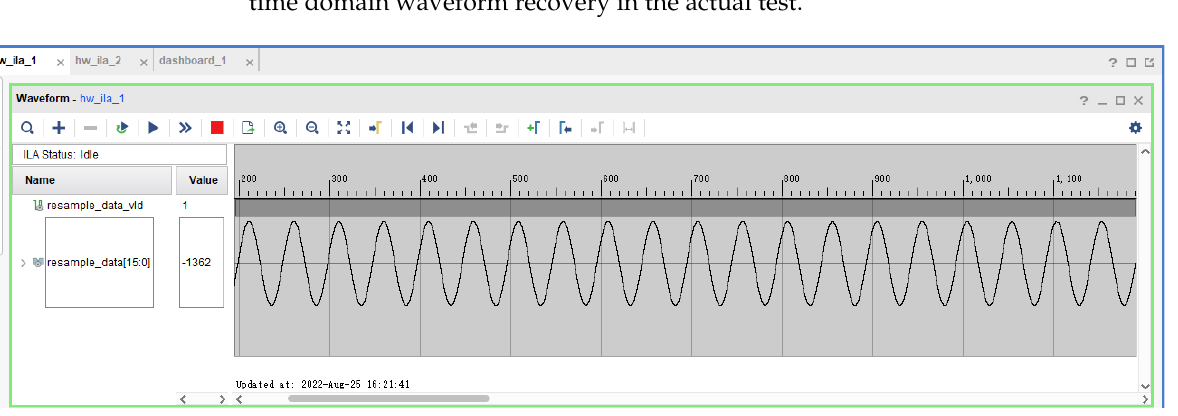
Figure 14. Actual test recovered time domain waveform.